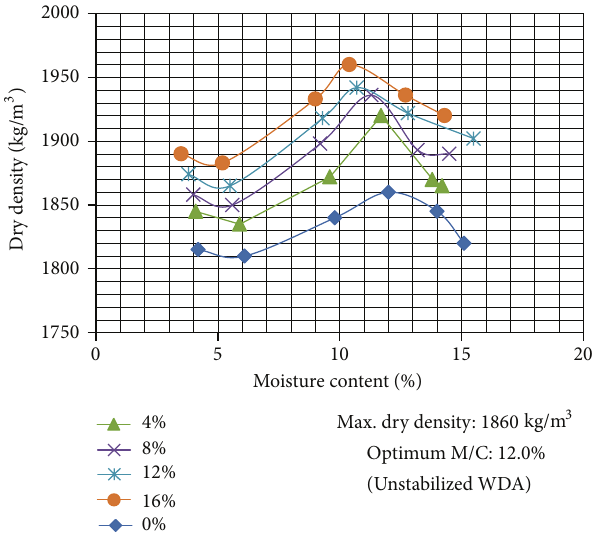
Figure 4: Compaction curve of fresh and stabilized WDA speci- mens at different contents of cement.